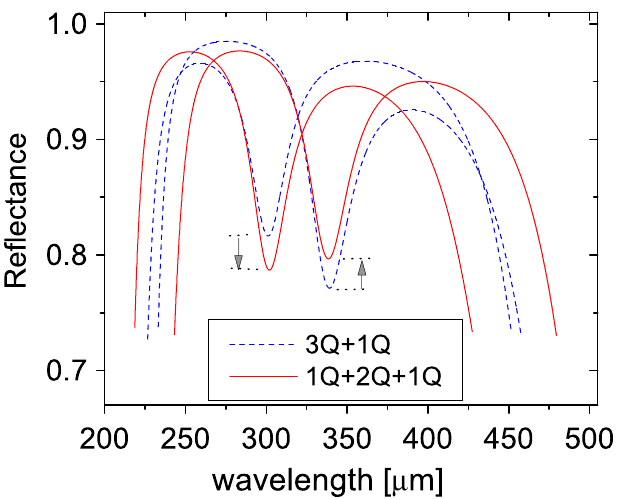
FIG. 10. (Color) Shifting high reflectivity bands as a means of extending the operational spectral range. In (a) measured and computed bands of a five layer ( (cid:1) 31 (cid:6) m thick) quartz stack. In (b) calculated spectra of a four layer 23 (cid:6) m thick Si wafer stack. Vacuum spacings: 75, 105, and 135 (cid:6) m ,